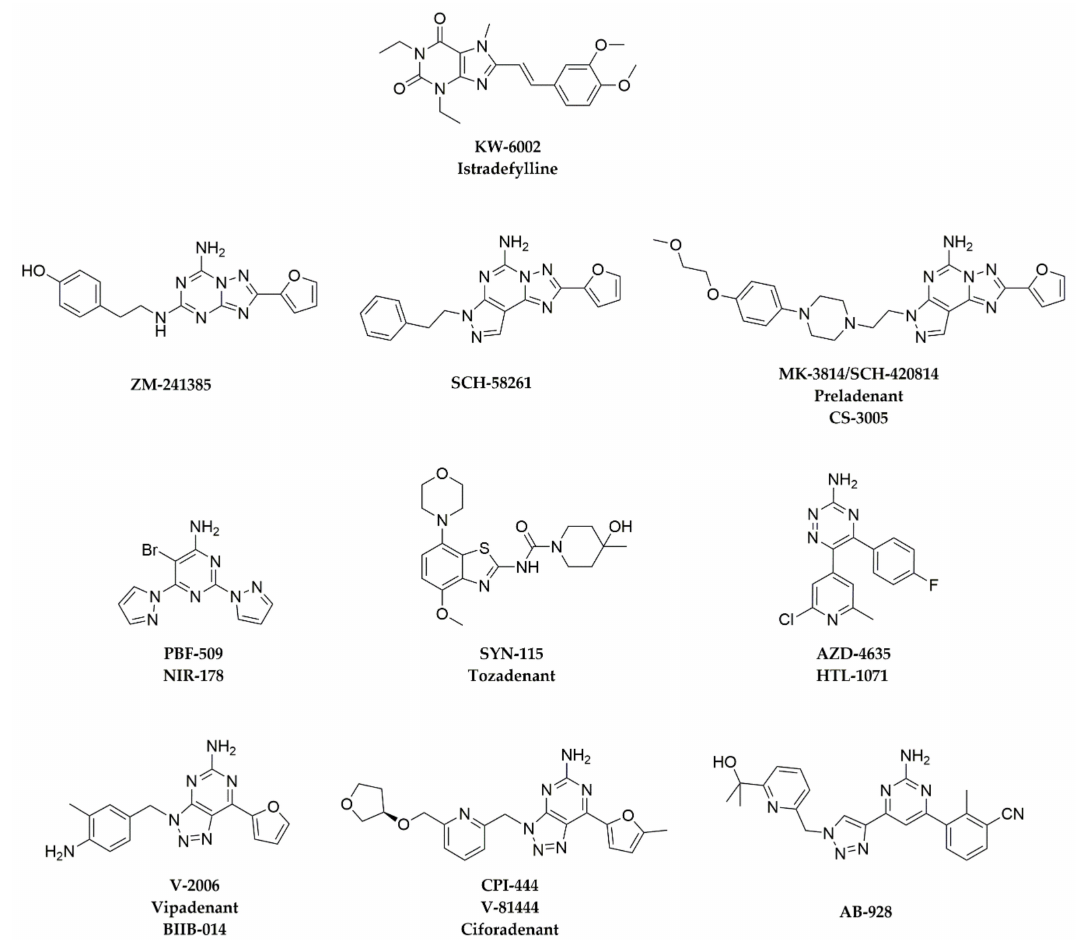
Figure 2. Chemical structures of A 2A AR antagonists discussed in this